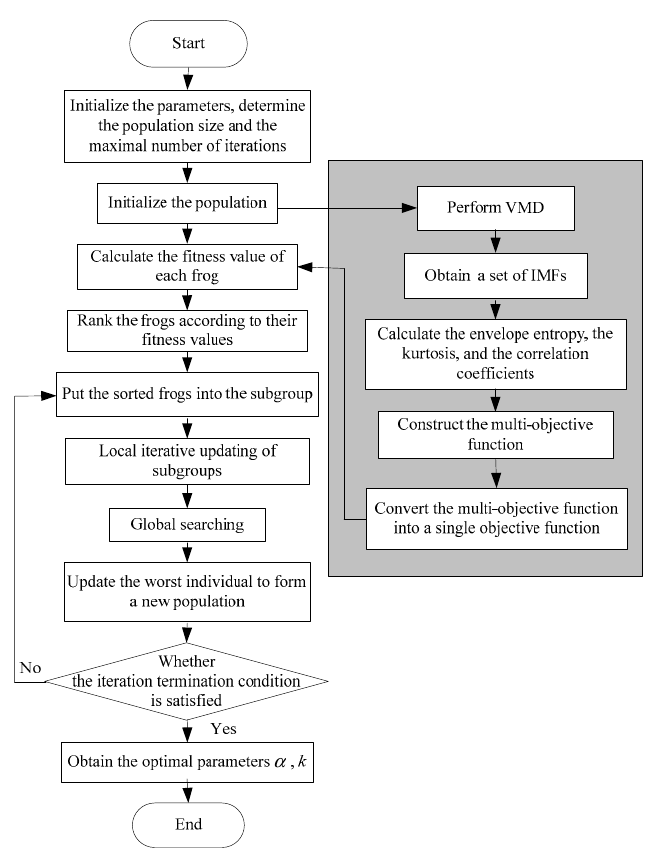
Figure 1. Flowchart of the parameter optimization by using the Shuffled Frog Leap Algorithm (SFLA).